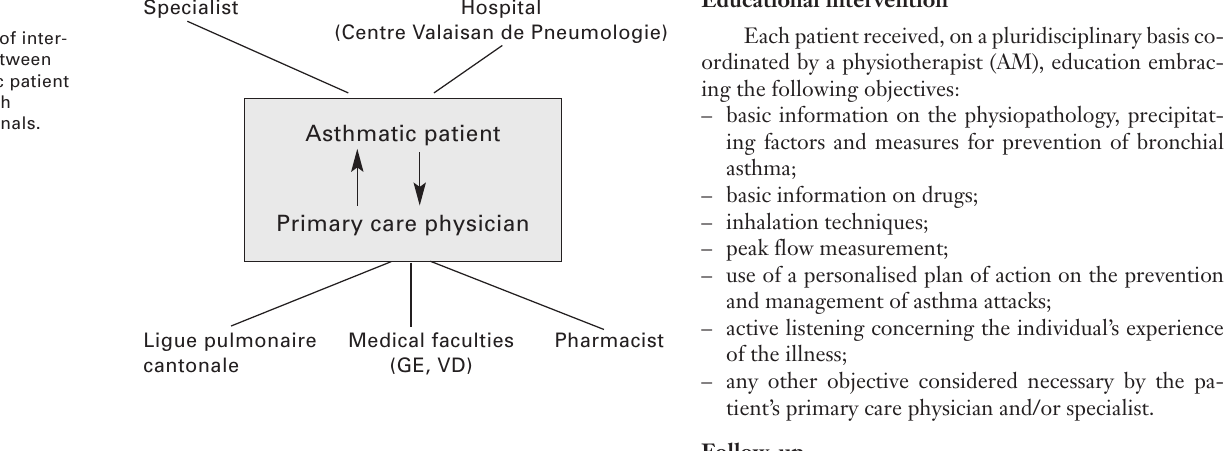
Diagram of inter- action between asthmatic patient and health professionals.